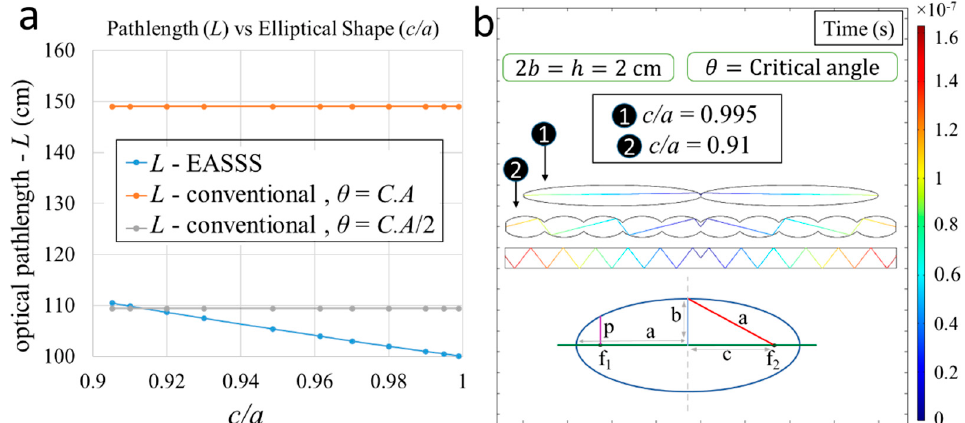
Figure 6. ( a ) Optical path lengths of radiation emitted from the center of the EASSS and conventional LSC panels for a structure with a width of 2 m. For the conventional LSC, the path lengths for emission at the critical angle for which TIR occurs ( θ = C.A. ) and for emission at half the critical angle are considered; and ( b ) Geometrical illustration of the ray propagation in conventional LSC and EASSS with c/a = 0.91 and 0.995 for h = 2 cm.